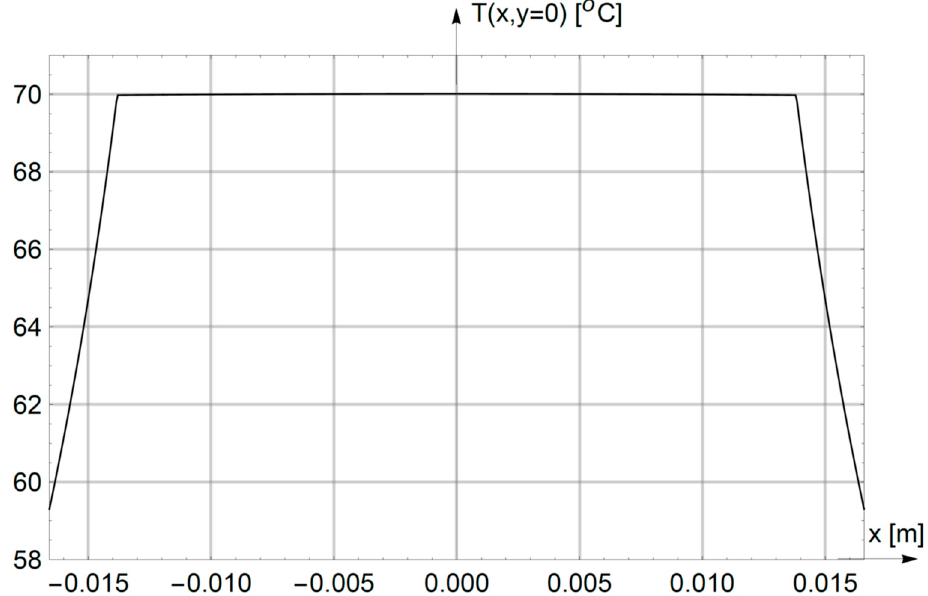
Figure 2. Temperature distribution on the major axis ( y = 0) of the elliptic conductor under current load I cr = 574.5 A.